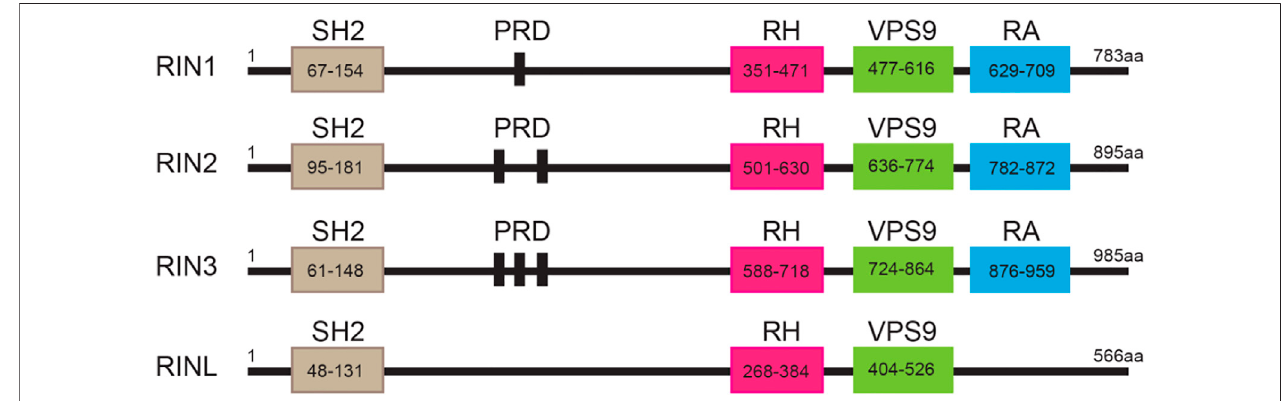
FIGURE 1 | Structure of the RIN protein family. Domain structures of individual RIN proteins. Functional domains with indicated residues are presented by frames. SH2,src homology2;PRD: proline-rich domain; RH:Rin homology; VPS9:vacuolarprotein sorting-associatedprotein 9;RA:Ras-association. Theaminoacidresidues for each of these domains are marked.